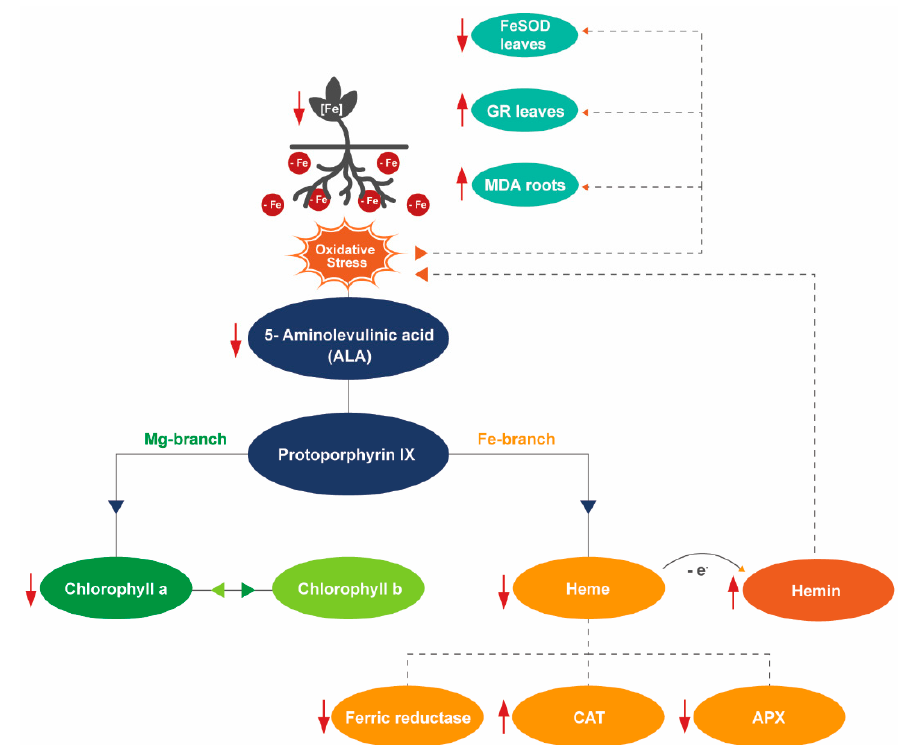
Figure 11. Proposed scheme for antioxidant responses and tetrapyrrole metabolism regulation of ine ffi cient (INF) plants under Fe deficiency ( − Fe). Full lines connect the main components of the tetrapyrrole cycle; dashed lines represent the influence of one product on another; red arrows represent increased (up) or decreased (down) concentration of a certain product. Figure S1: List of enzymes investigated in this work accompanied with reactions they catalyze, their EC numbers, and genes in soybean that encode proteins related to these specific EC functions. Soybean genome annotation v1.1 was searched for specific enzyme functions (by using EC no as search string) and genes encoding related proteins were listed. Reactions related to specific EC functions were taken from EXPASY